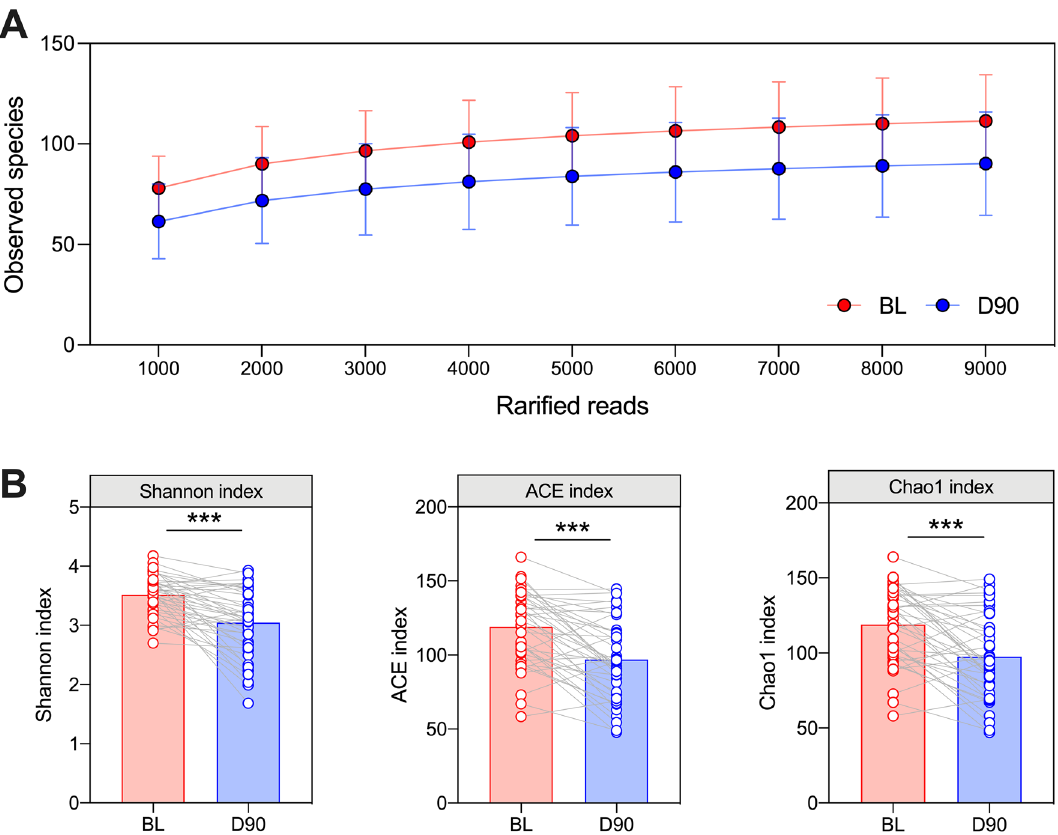
Figure 2. Alpha-diversity of subgingival plaque samples. Rarefaction curves for observed species at baseline (red line) and day-90 (blue line) ( A ). Comparing Shannon, ACE and Chao1 indexes before and after treatment at species-level rarefied to 9000 reads ( B ). Statistics are paired t-test, *** p < 0.001. n = 42. Bars represent mean with individual values